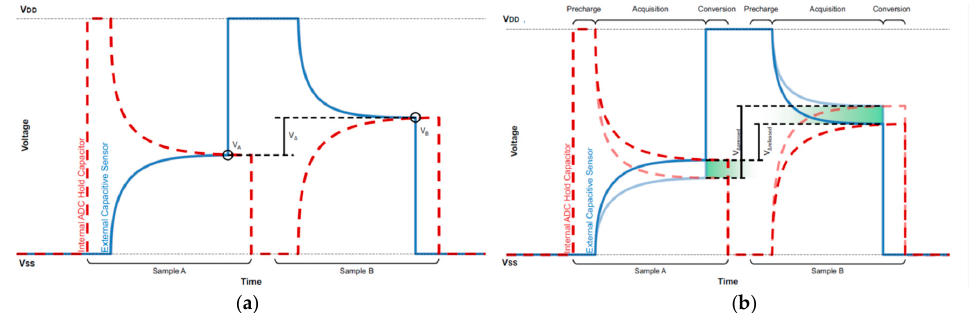
Figure A2. ( a ) Differential CVD waveform; and ( b ) difference between pressed and released differential values [30].